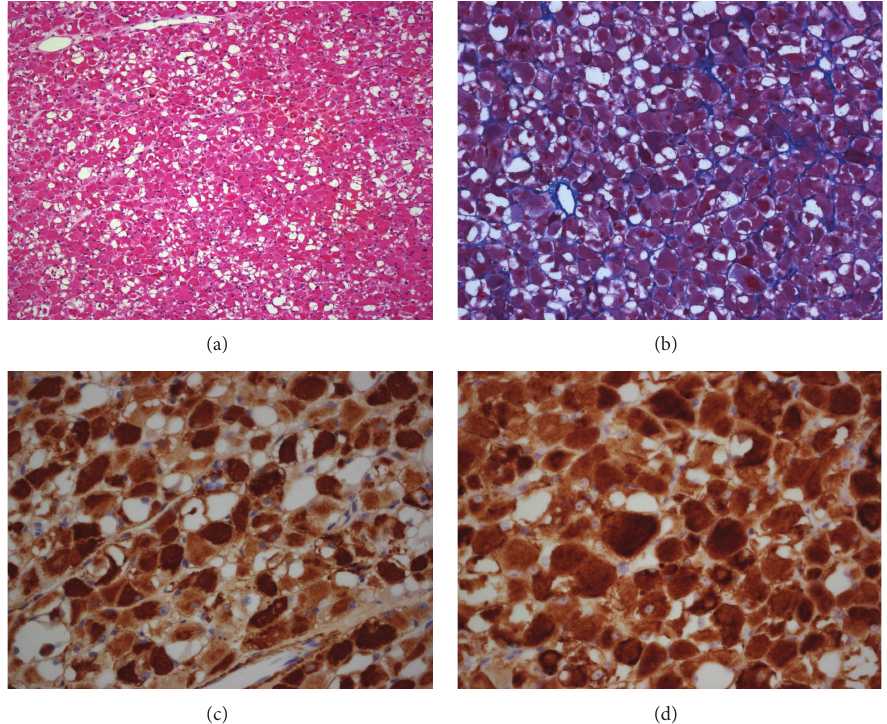
Figure 2: Histopathology and immunohistochemistry of the lesion. Microscopic examination showing large polygonal cells with eosinophilic and vacuolated cytoplasm (hematoxylin and eosin stain; original magnification: 20x) (a), Masson’s trichrome staining demonstrating red round, oval, and polygonal cells (original magnification 20x) (b), immunohistochemical stain showing strong positivity against muscle- specific actin (c), and desmin antigens (d) (original magnification, 40x).